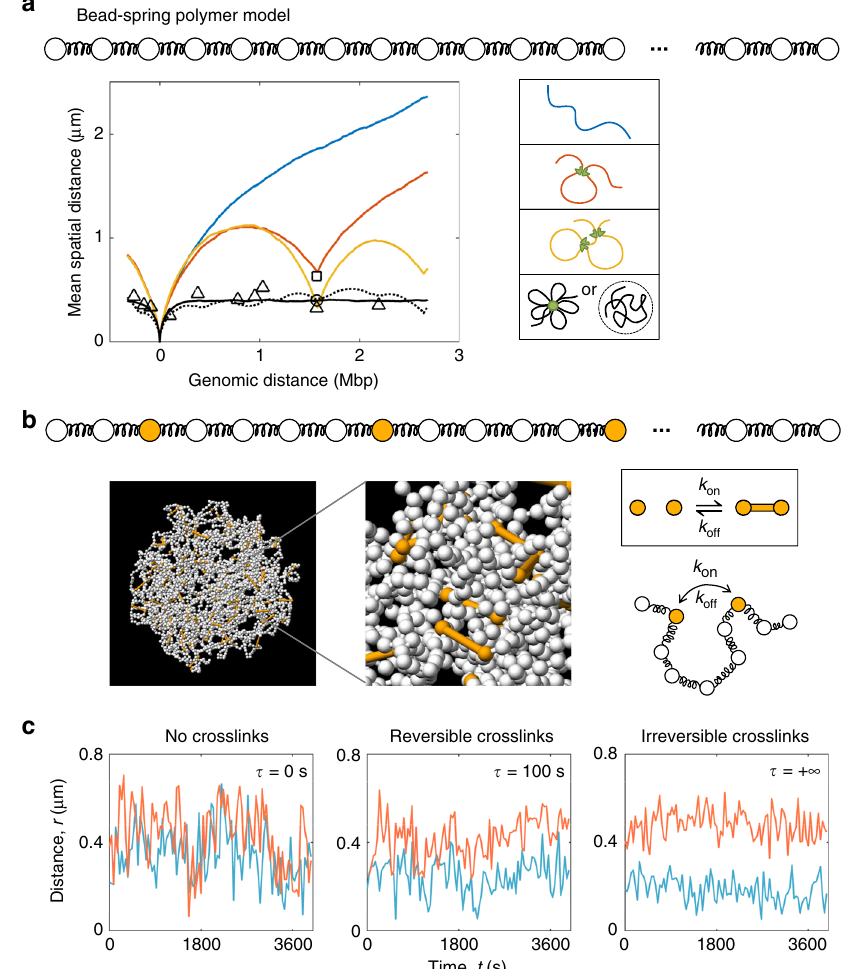
Fig. 4 Molecular dynamics simulations capture Igh locus structure and dynamics. a The mean spatial separation as a function of the genomic distance between the D H J H and the markers that span the V H regions are indicated. Triangles represent the mean spatial separation between the marked regions and the D H J H elements as measured previously by 3D-FISH 49 . Note that the plotted average values were obtained for > 100 RAG-de fi cient pro-B cells for all shown data points 49 . The square and circle represent the mean spatial separation between the D H J H region and the V H 3 regions cultured in the absence ( n = 121) or presence ( n = 45) of STI-571, respectively. Colored lines show spatial separation as a function of genomic distance for the IgH locus modeled as an unstructured chromatin chain (blue line), a single loop con fi guration (red line) or a two-loop con fi guration (orange line). Right panel indicates the different con fi gurations that were analyzed. b A snapshot extracted from MD simulations of the bead-spring polymer model with cross-linkable sites spanning the Igh locus. c Two representative trajectories of V H -D H J H spatial distances from simulations (red and blue lines) demonstrate how the insertion of crosslinks across the locus in the simulations reproduces the experimentally observed “ demixing ” of the trajectories. Source data is provided as a